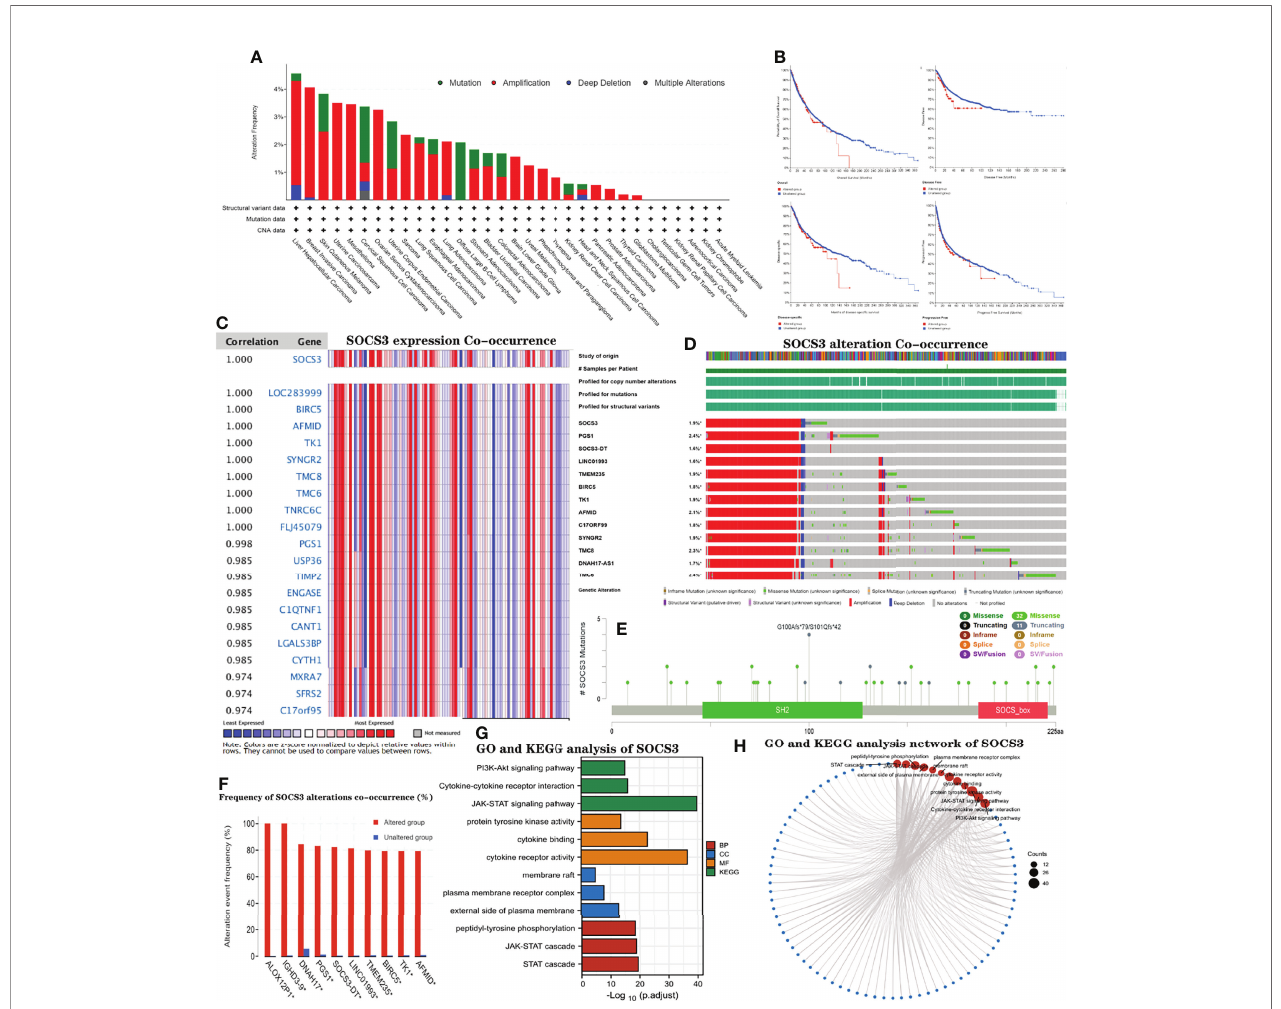
FIGURE 9 | Genetic diversities and oncogenic characteristics of SOCS3 co-occurrence with dysregulation of its functional chaperone and may predict poor prognosis of cancers. The mutation features of SOCS3 in TCGA cancers were explored via cBioPortal database, (A) displayed the mutation frequency and (E) showed the mutation site. (B) Kaplan – Meier curves of the in fl uence of SOCS3 alterations on OS, DSS and PFS. (C) Heatmap indicated SOCS3 overexpression co-occurrence via Oncomine database. Spearman ’ s rho value and estimated statistical signi fi cance were employed to re fl ect the degree of relevance between these genes. (D) Displayed SOCS3 alteration co-occurrence genes, including PGS1, SOCS3-DT, LINC01993, TMEM235, BIRC5, TK1, AFMID, C17ORF99, SYNGR2, TMC8, DNAH17-AS1 , and TMC6. (F) Frequencies of ALOX12P1, IGHD3-9, DNAH17, PGS1, SOCS3-DT, LINC01993, TMEM235, BIRC5, TK1 , and AFMID alteration co-occurrence with SOCS3 alterations. (G, H) Co-occurrence GO and KEGG enrichment analysis of SOCS3 in different